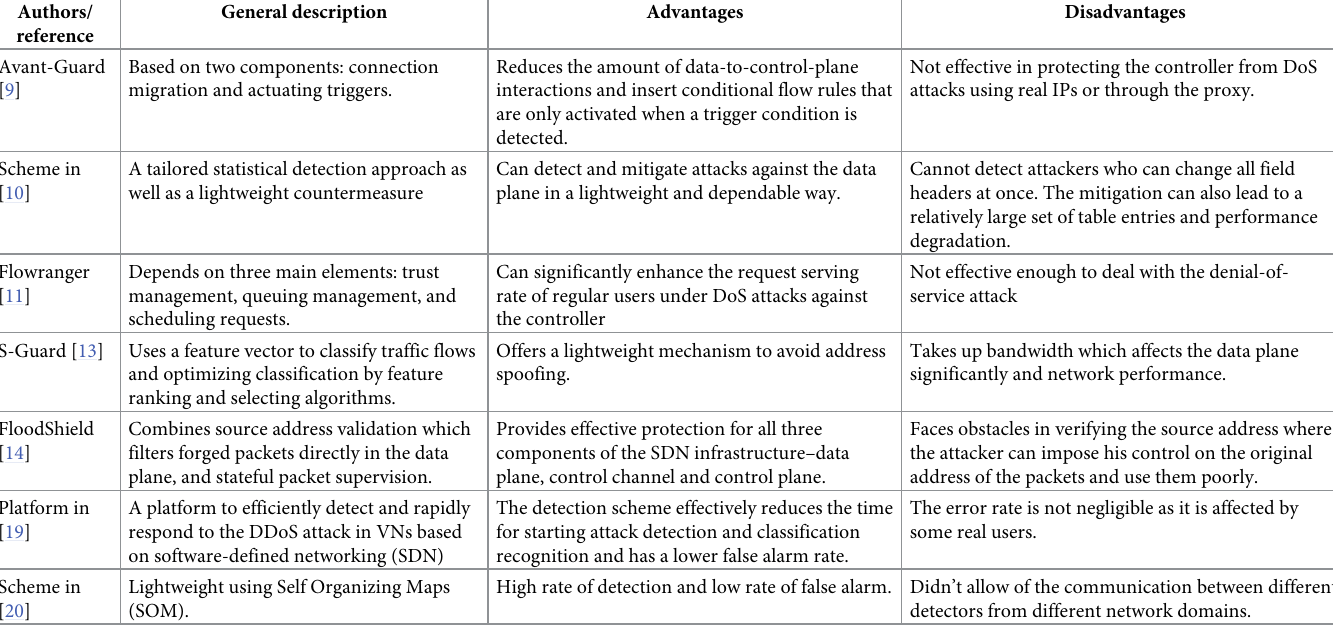
Table 1. Summary of our literature